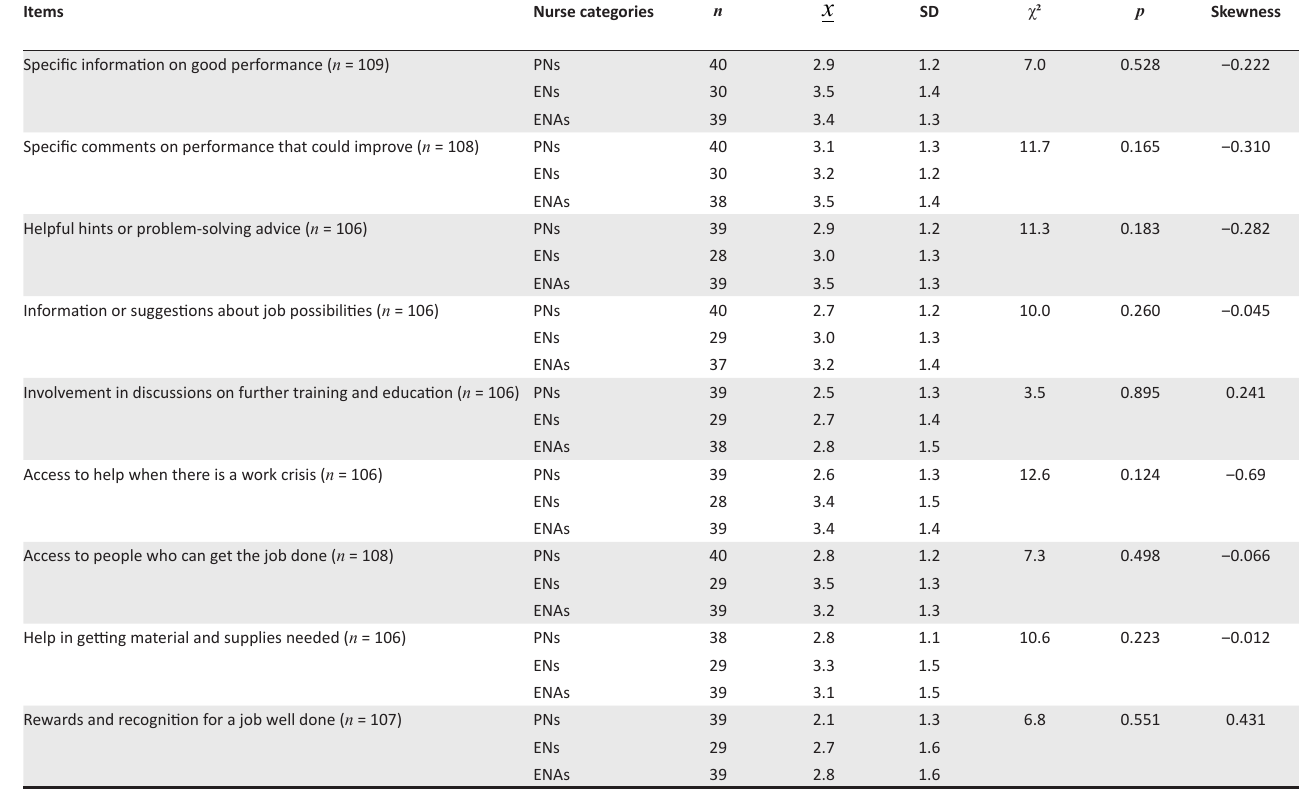
TABLE 3: Items on access to support as a source of power for structural empowerment.